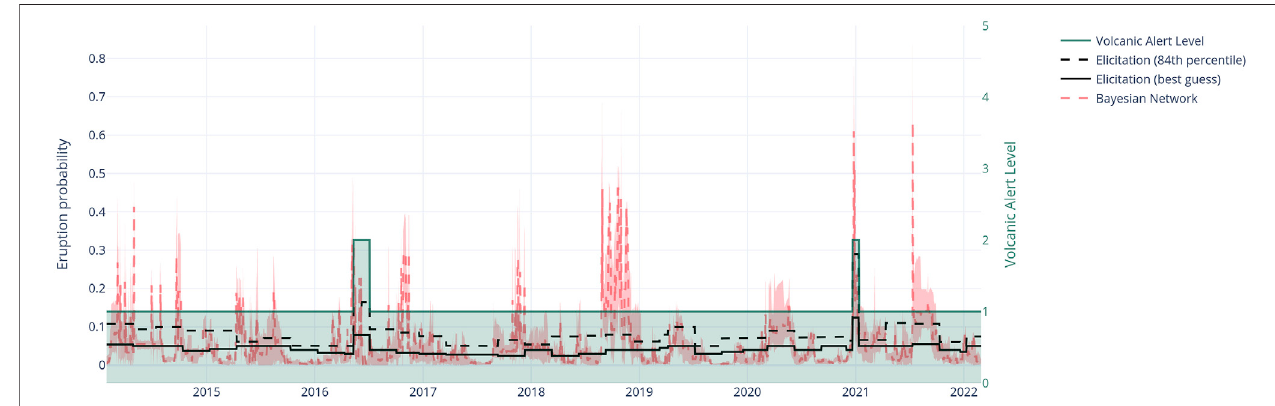
FIGURE 8 | Ruapehu BN time series from 2014 to 2022. The red dashed line shows the BN forecast with its 90% con fi dence interval shown in shaded pink. The solid black line shows the median forecast of VMG elicitations with the black dashed line showing their 84th percentile. The green line and shaded area indicates the Volcanic Alert Level at Mt